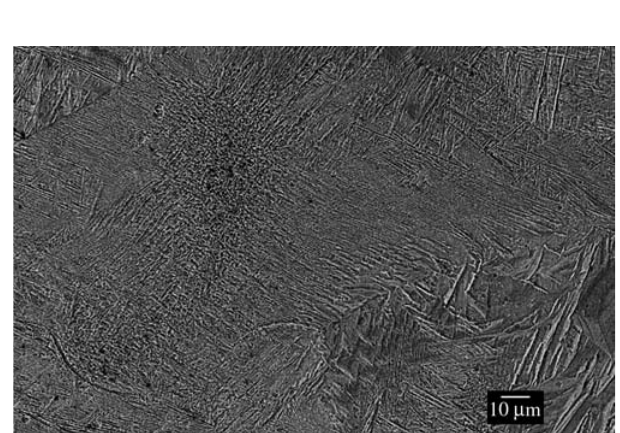
conditions.(b) Figure 5. Micrographs at same scale from SEM showing central regions in welds obtained in a) normal; and b) optimized